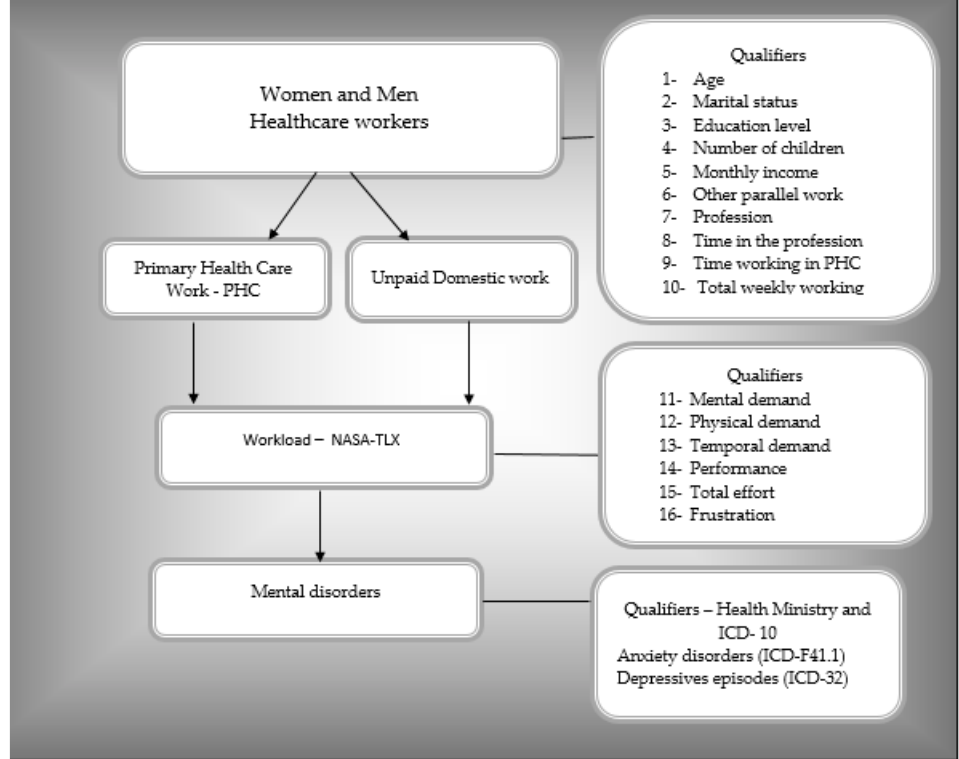
Figure 1. Outline of the main concepts used (PHC workload and unpaid domestic work; mental disorders (anxiety disorders and episodes of depression)) and their qualifiers to investigate the magnitude of the problem among female and male primary health care professionals.